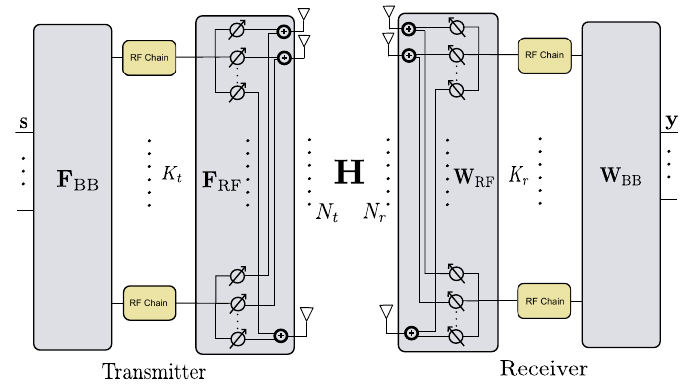
Figure 1. The phase shifter-based hybrid